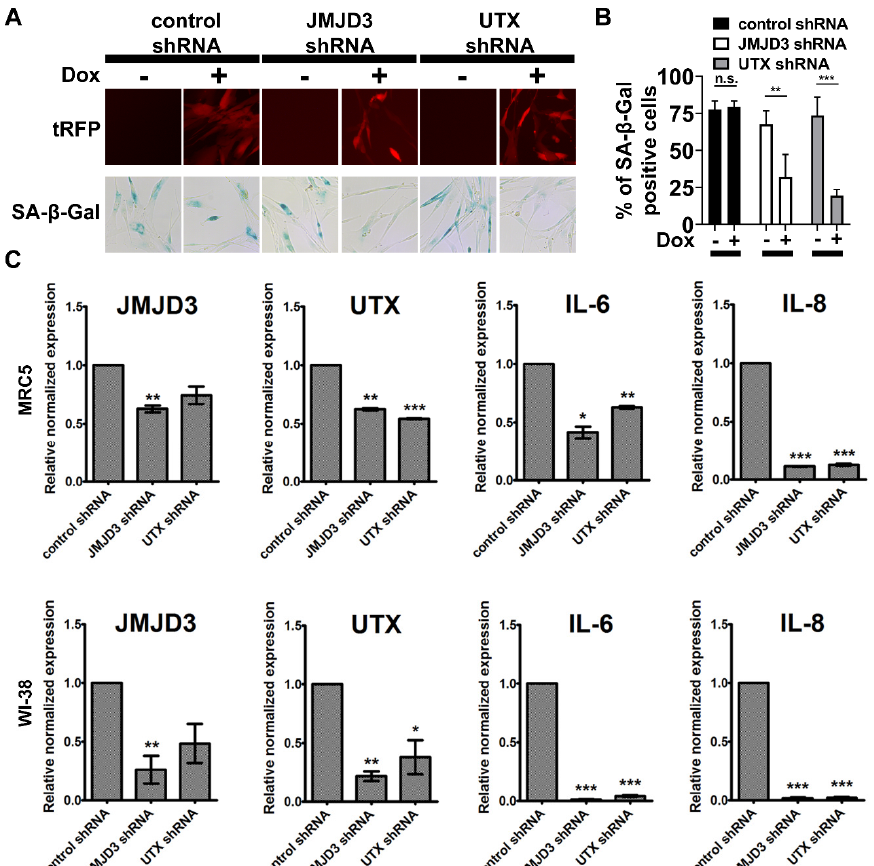
Figure 5. shRNA knockdown of H3K27 demethylases reduces senescence-associated biomarkers. ( A ) Representative fluorescence microscopy images of MRC5 cell lines grown in SCM and expressing shRNAs targeting Jmjd3 and Utx. The addition of doxycycline (Dox) at 2 µg/mL activated each shRNA, as indicated by turbo red fluorescent protein (tRFP) reporter expression. Representative images show SA- β -gal staining at 48 h. ( B ) Quantification for SA- β -gal staining shown in A. ( C ) RT-qPCR analysis for the expression levels of H3K27 demethylases and SASP genes in control, Jmjd3, and Utx shRNA cell lines at 72 h. ( B , C ) Student's t-test; bars represent standard deviation and asterisks indicate statistical significance (n.s., not significant; *, p ≤ 0.05; **, p ≤ 0.01; ***, p ≤ 0.001; n = 3).